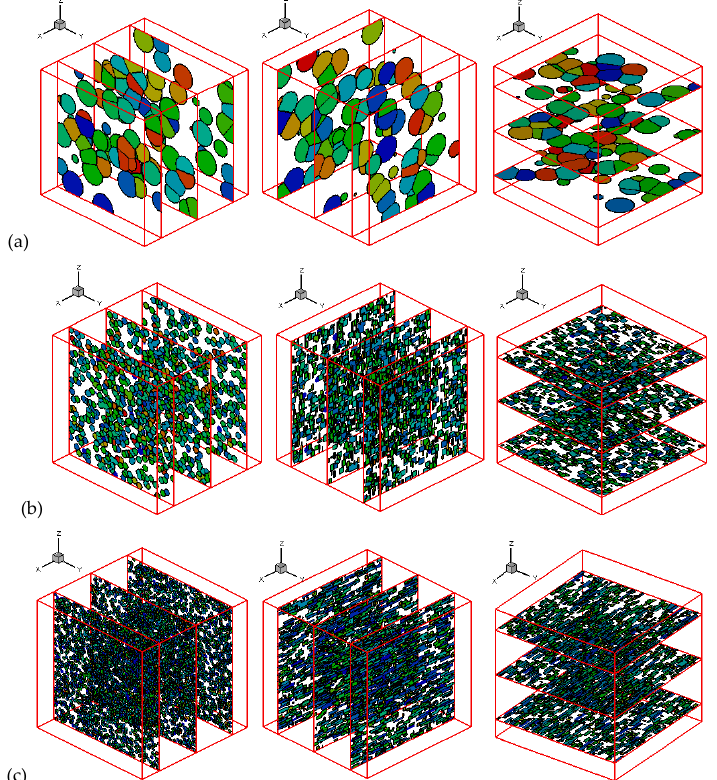
Figure 6. Morphology comparison with different shear rates ( α ≈ 0.5). ( a ) . γ = 0s − 1 ; ( b ) . γ = 5s − 1 ; . γ = 10s − 1 and ( c )